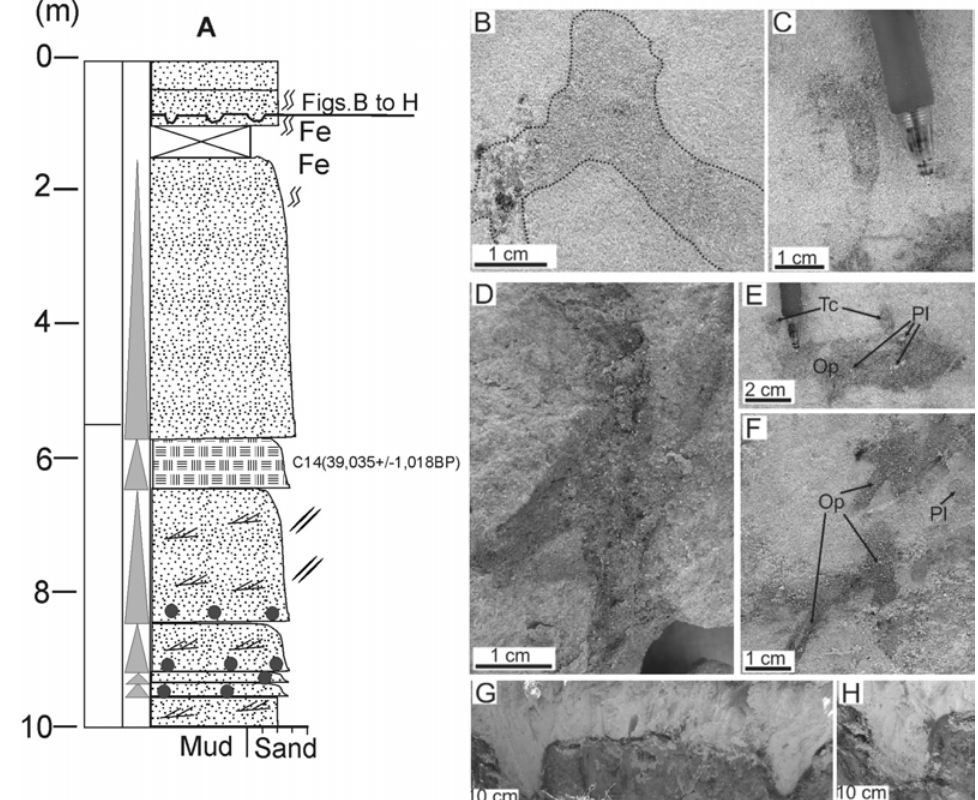
Fig. 4 – Drill #2 (main channel to the south). A) Lithostratigraphic profile illustrating facies characteristics and vertical facies distribution. B to F) Trace fossils observed above and below the discontinuity surface at the top of the succession, illustrating: Ophiomorpha (B); Diplocraterion (C); Thalassinoides (D); Ophiomorpha (Op), Teichichnus (Tc) and Planolites (Pl) (E); and Ophiomorpha (Op) and Planolites (Pl) (F). G-H) General view (G) and detail (H) of large burrows developed upon the discontinuity surface of the top of the succession, probably related to feeding activity of rays. (See Figure 2 for drill